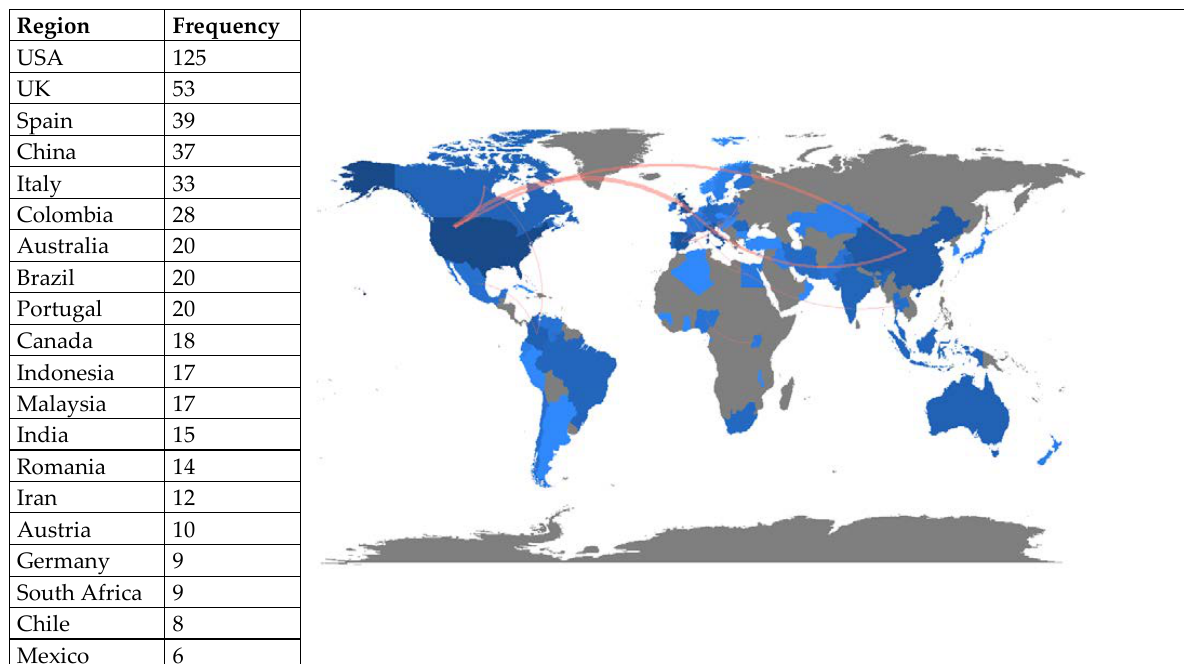
18 of 23 Figure 14. Top affiliation of institutions by authors.